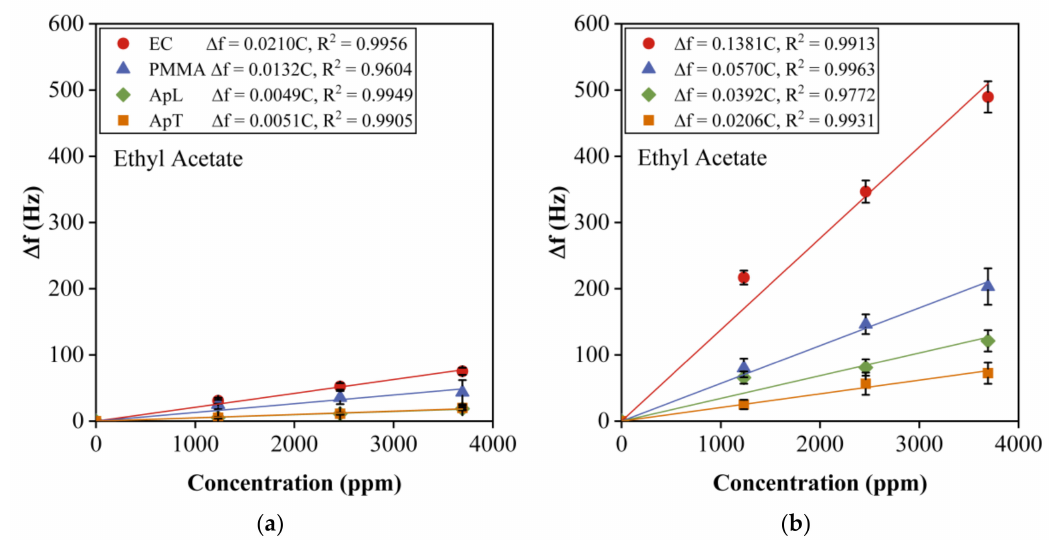
Figure 4. Response curves due to exposure to ethyl acetate (1230, 2460, and 3690 ppm) for sensors with EC, PMMA, ApL, and ApT sensing films, ( a ) 12 MHz, and ( b ) 30 MHz. The sensing film thickness was ~0.2 µ m, at T = 20 ◦ C, and RH = 22%. The maximum deviation was 13% error